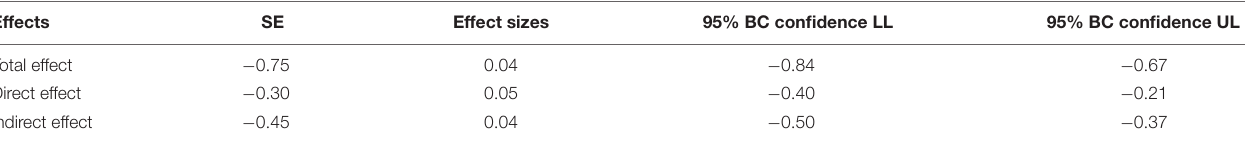
TABLE 5 | The mediating effect of lack of goal progress (LOGP) on the relationship between red tape and proactive behavior.